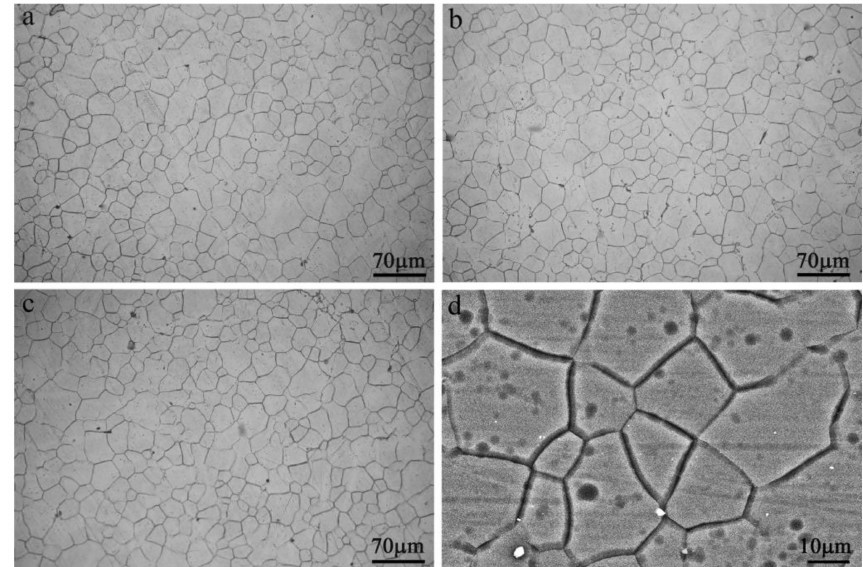
Figure 8. Optical images of the ( a ) longitudinal section, ( b ) outside surface and ( c ) cross section for the solution-treated ZM51 alloy tube, and ( d ) BSE-SEM image of the outside surface of the solution-treated ZM51 alloy tube.